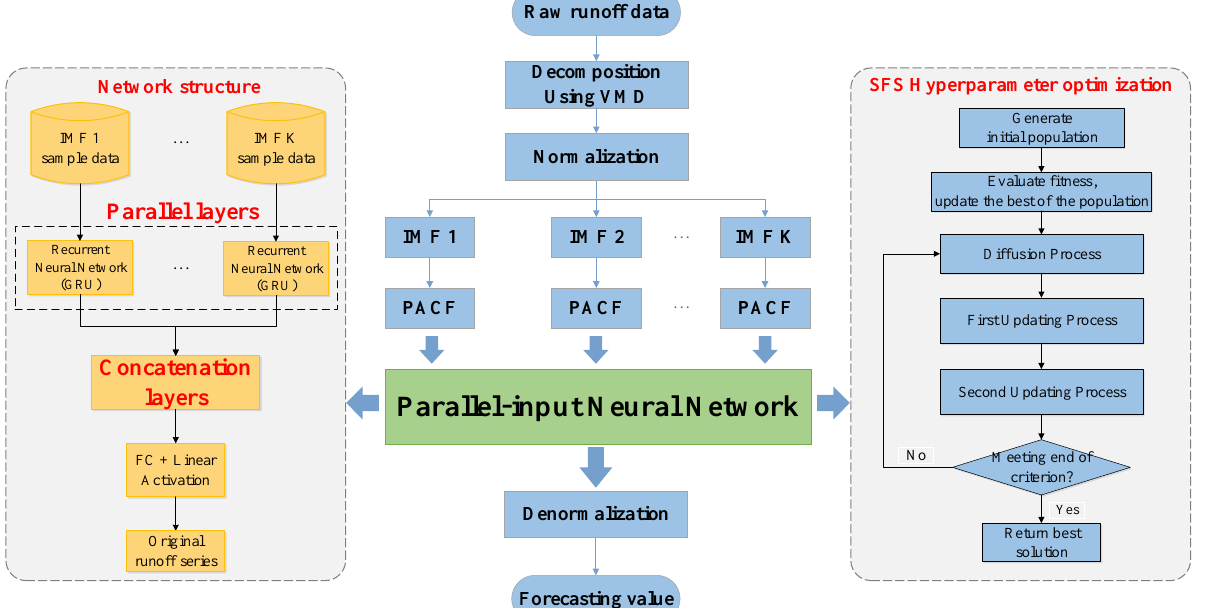
Figure 2. A block diagram of the proposed runoff forecasting model based on the DIP framework.